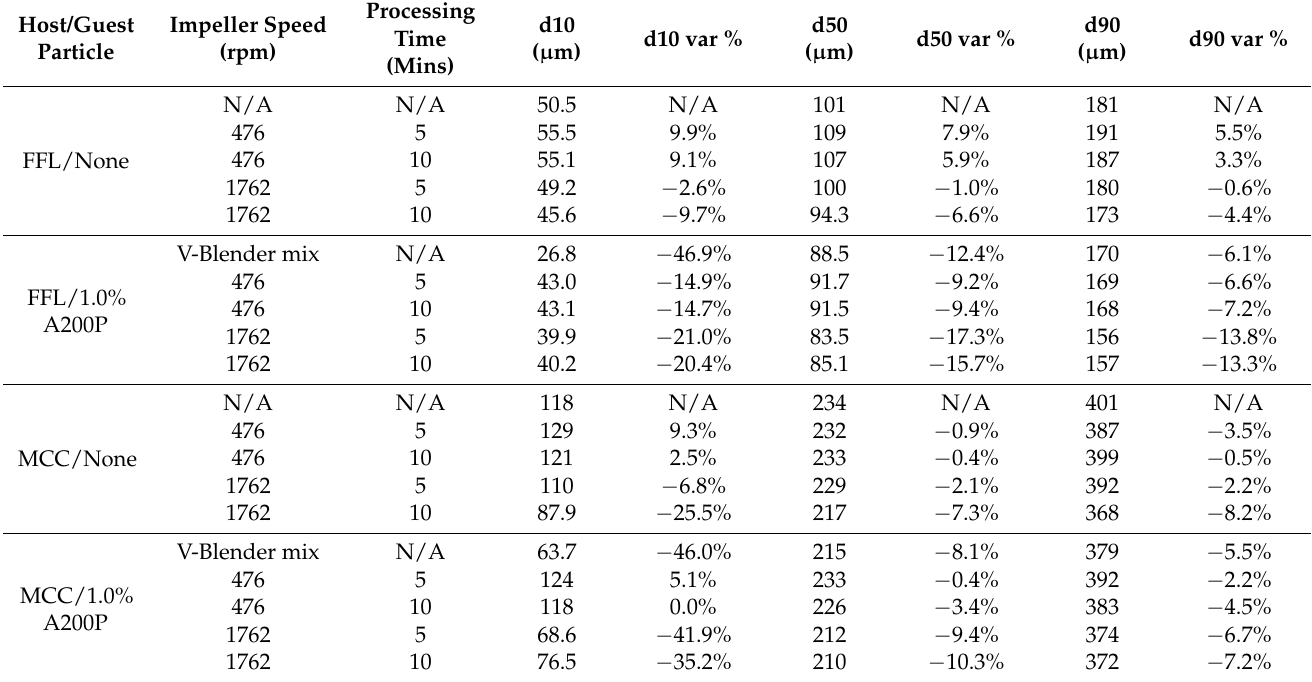
Table 2. Particle size distribution results of the preliminary batch mode